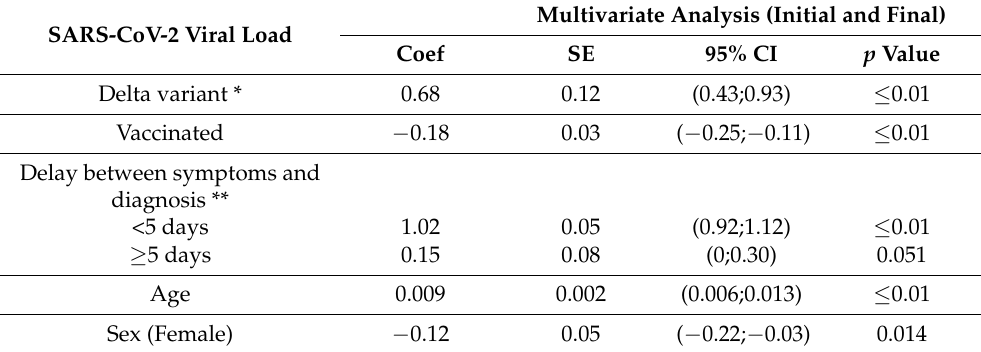
Table 3. Multivariate analysis of the nasopharyngeal viral load (Adjusted R-squared = 0.13, F = 91.2). SARS-CoV-2 Viral Load